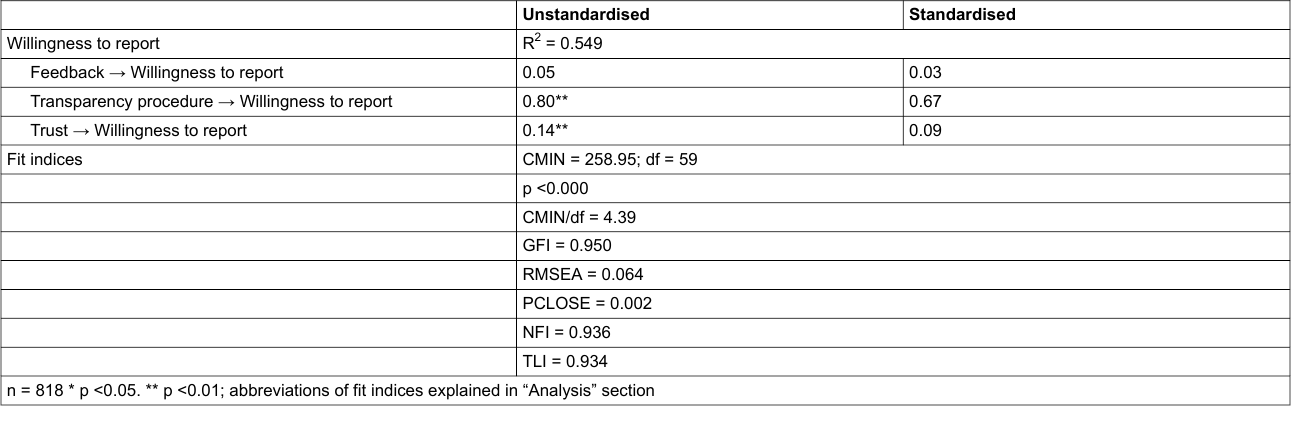
Table 8: Path coefficients and general fit indices of the integrated structural model.